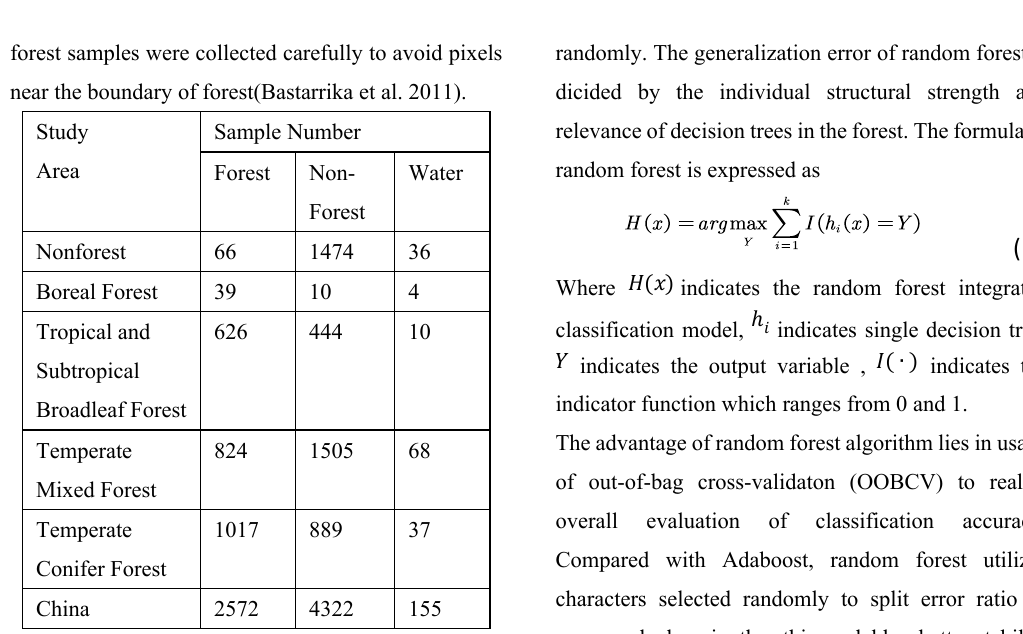
Table 2.The training sample numbers for the forest ,nonforest and water in each partition.